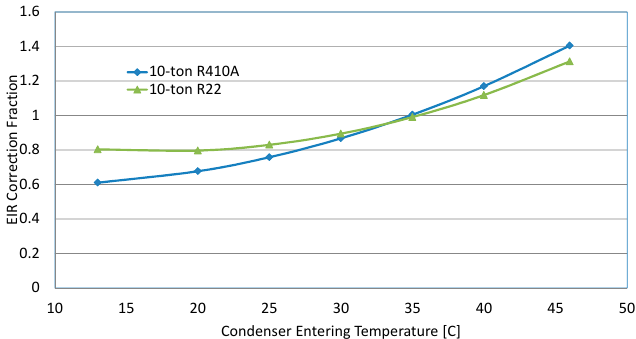
Figure 3. EIR correction ratios of R-22 and R-410A varying with outdoor air temperature and fixing indoor WB at 67 °F (19.4 °C).